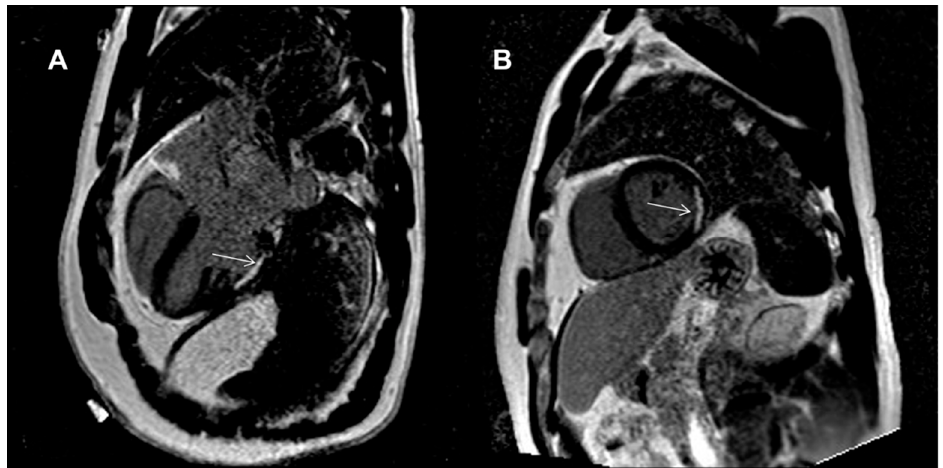
Figure 3. Example of subendocardial LGE in the lateral wall encompassing 50–75% of the myocardial wall thickness and causing myocardial akinesis in that segments with preserved left ventricular ejection fraction found in the 41-year-old male without previously known myocardial infarction. ( A ) 3-chamber view;( B ) short axis mid-ventricular view (LGE is marked with an arrow).